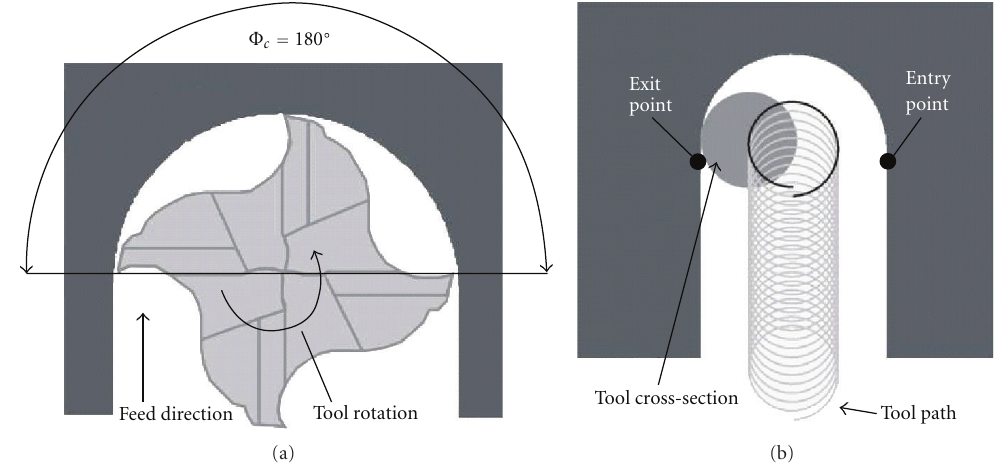
Figure 2: (a) Conventional slot milling; (b) Circular milling.